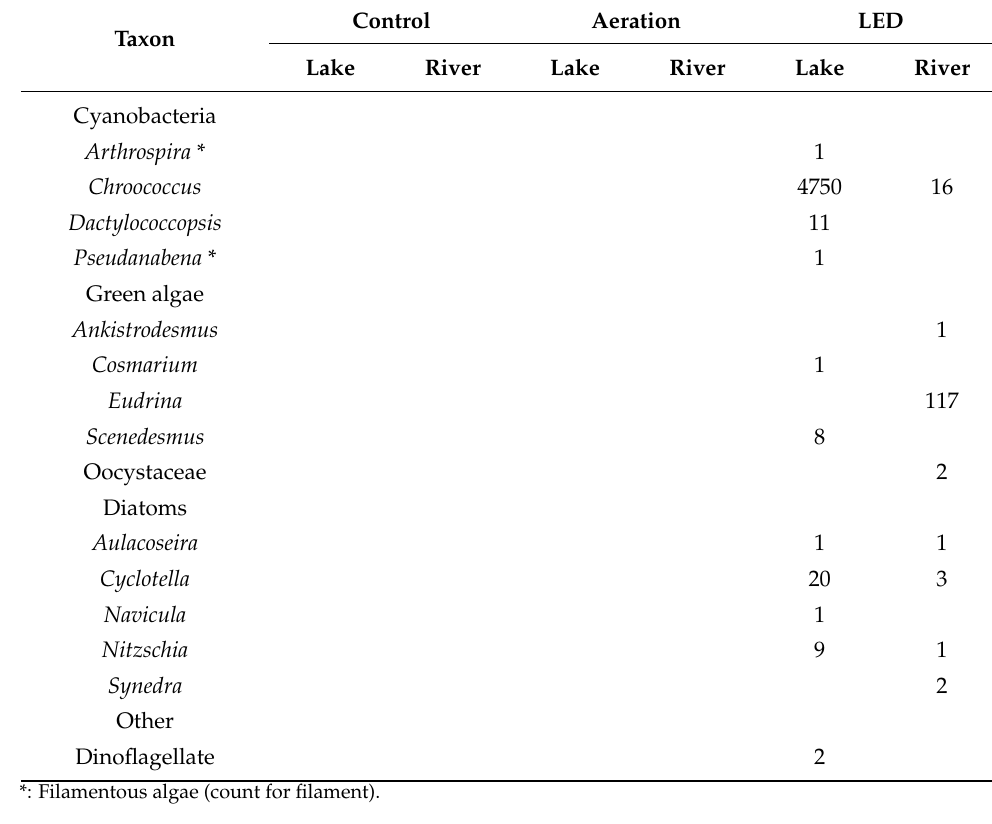
Table A1. Density (cell mL − 1 ) of phytoplankton cells in each condition on day 28. No phytoplankton was found in the control and aeration treatment.